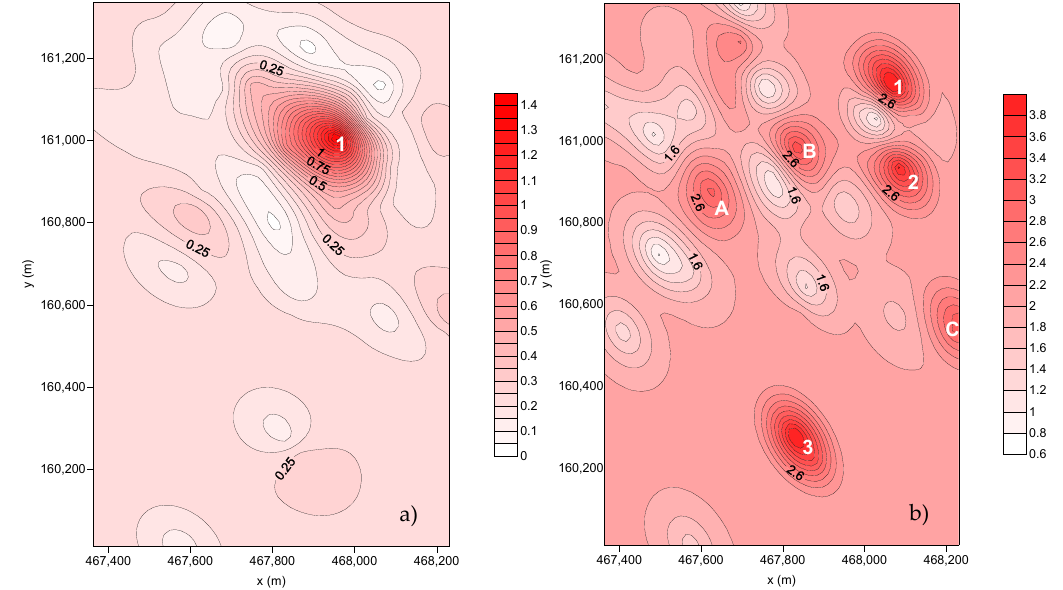
Figure 7. Spatial distribution of the dust flux deposition (g m –2 month –1 ): (a) SC6 and (b) SC7.